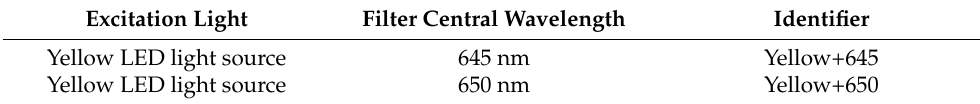
Table 2. Excitation light source and filter configuration scheme for fluorescent maize